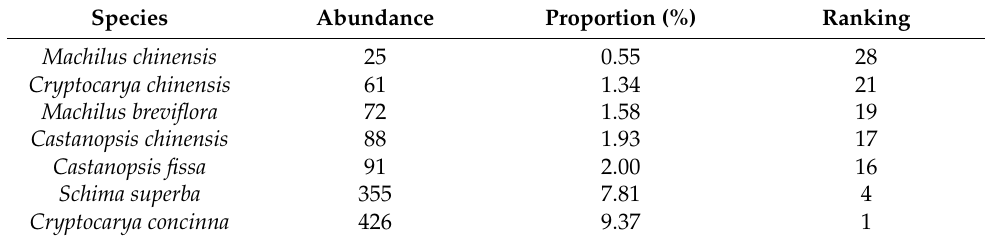
Table A1. Abundance of the seven target species.